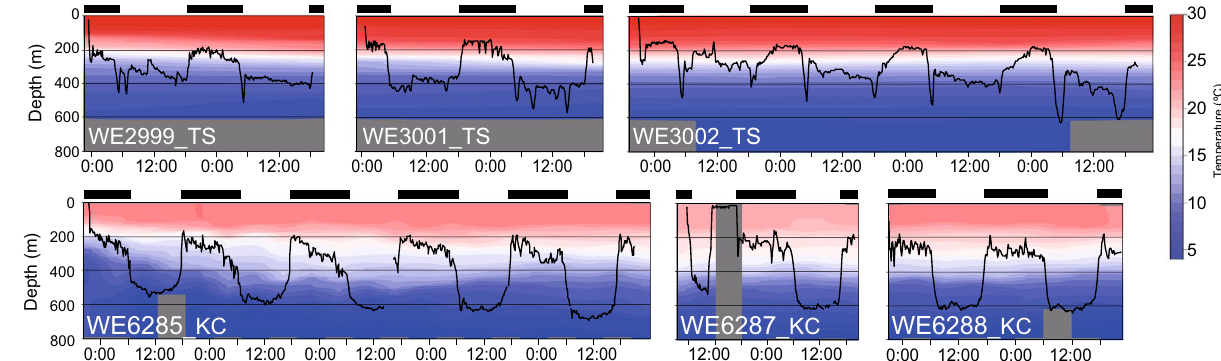
Figure 4. Vertical migration behavior of six eels and temperature structures. The swimming depths of three eels (WE2999_TS, WE3001_TS, WE3002_TS) released in the tropical–subtropical area and three eels (WE6285_KC, WE6287_KC, WE6288_KC) released in the Kuroshio Current area were written by black lines. The vertical profiles of temperatures in the eels’ swimming place were drawn using color coded from blue (5 °C) to red (30 °C). No temperature data was available for gray area. Black bars indicate